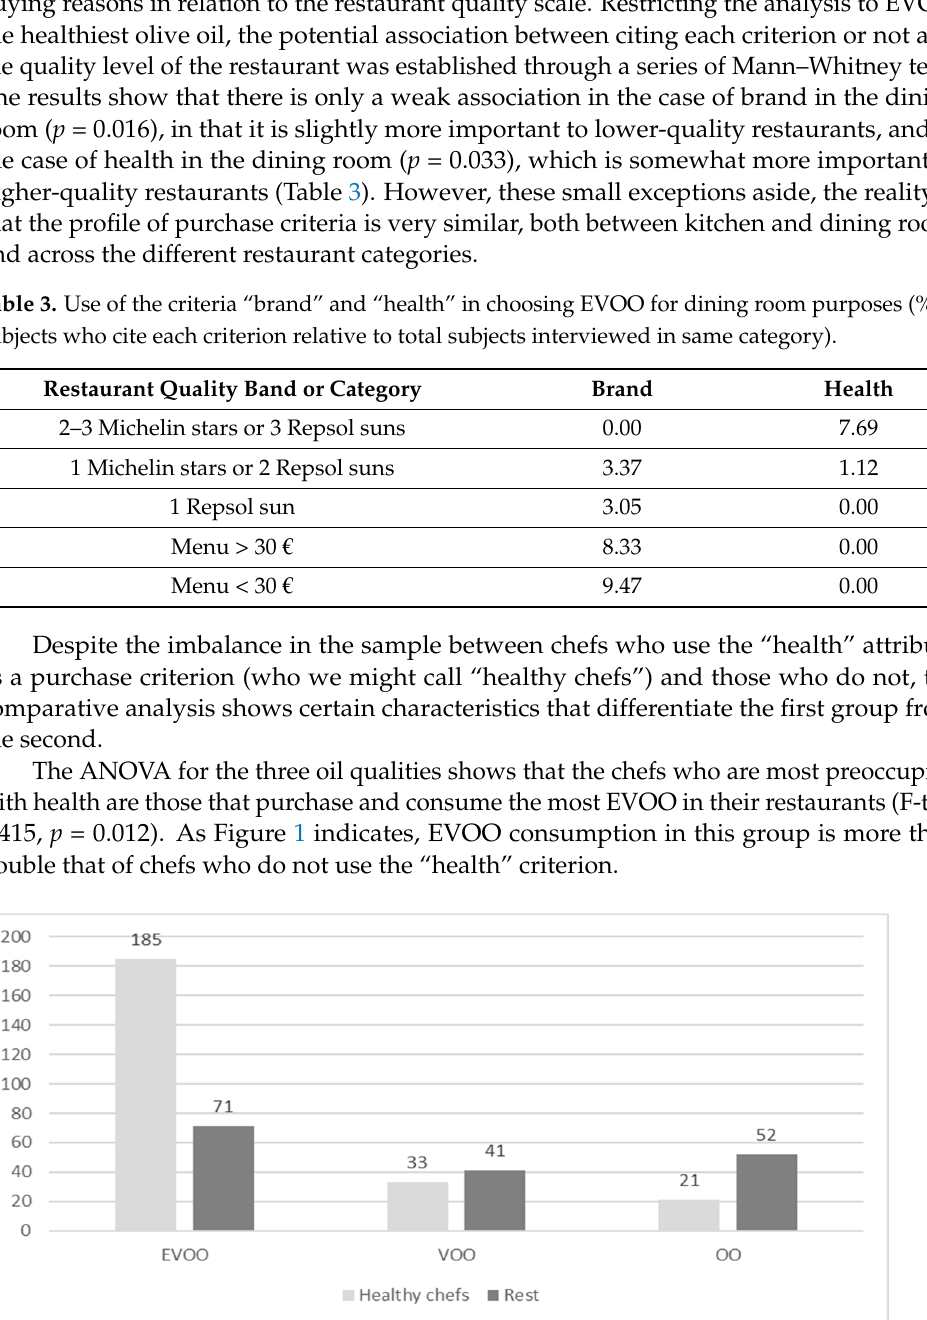
Table 3. Use of the criteria “brand” and “health” in choosing EVOO for dining room purposes (% of subjects who cite each criterion relative to total subjects interviewed in same category).